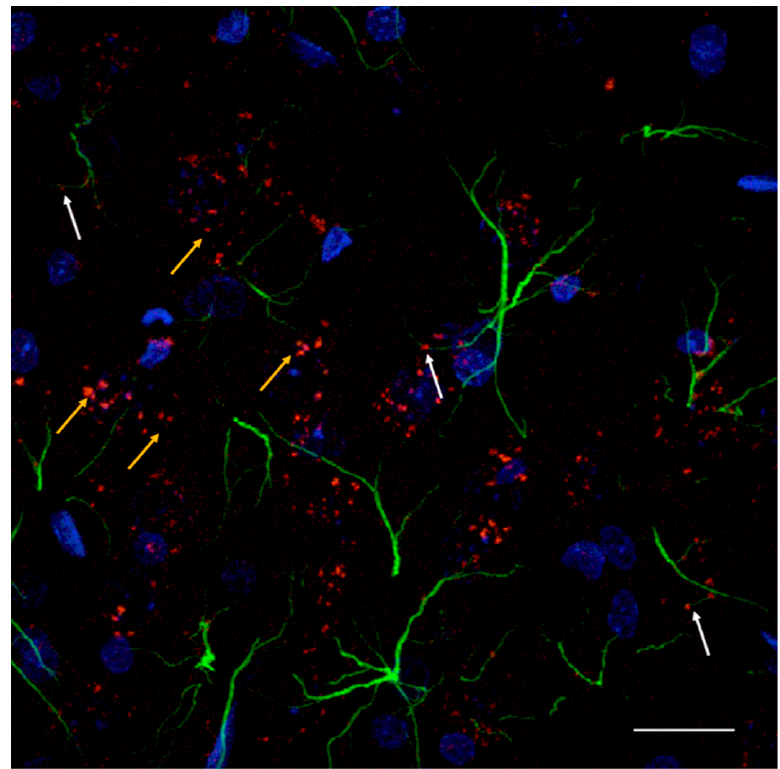
Figure 3. In the nucleus accumbens shell A2AR-D2R heteroreceptor complexes were demonstrated both in astrocytes and in nerve cells. The astrocytes were visualized in green color with GFAP antibodies (glial fibrillary acidic protein immunoreactivity). The nerve cells were not visualized. PLA positive A2AR-D2R hetero complexes were found as clusters in high densities. White arrows point to the red PLA clusters in green labeled astroglia. Most of the red clusters are not associated with the astroglia (yellow arrows) and are most likely present in the accumbal neurons rich in GalR1 and GalR2 and 5-HT1ARimunoreactivities.